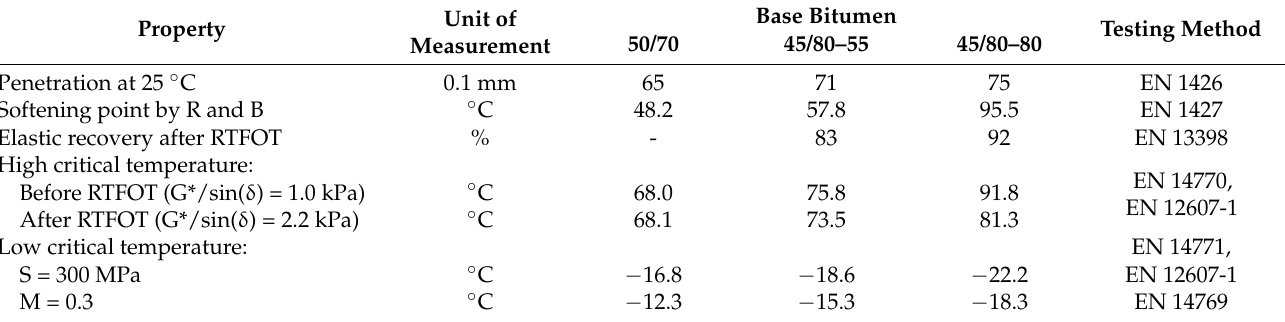
Table 1. Properties of the base